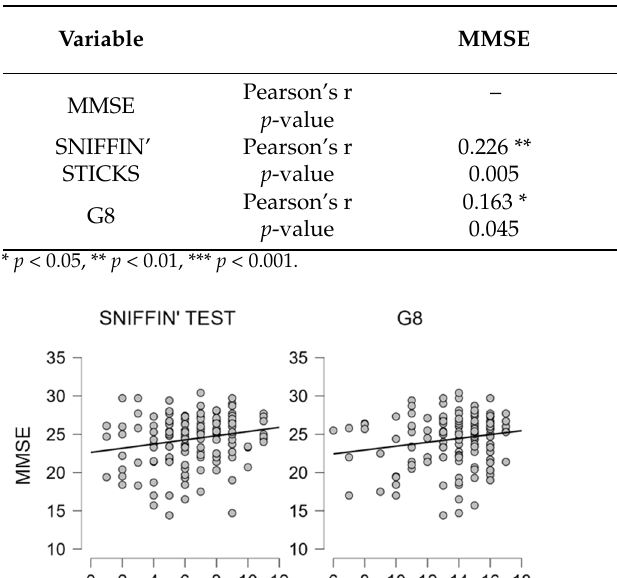
Table 5. Pearson’s coefficient and and p -value for significant correlations are reported.